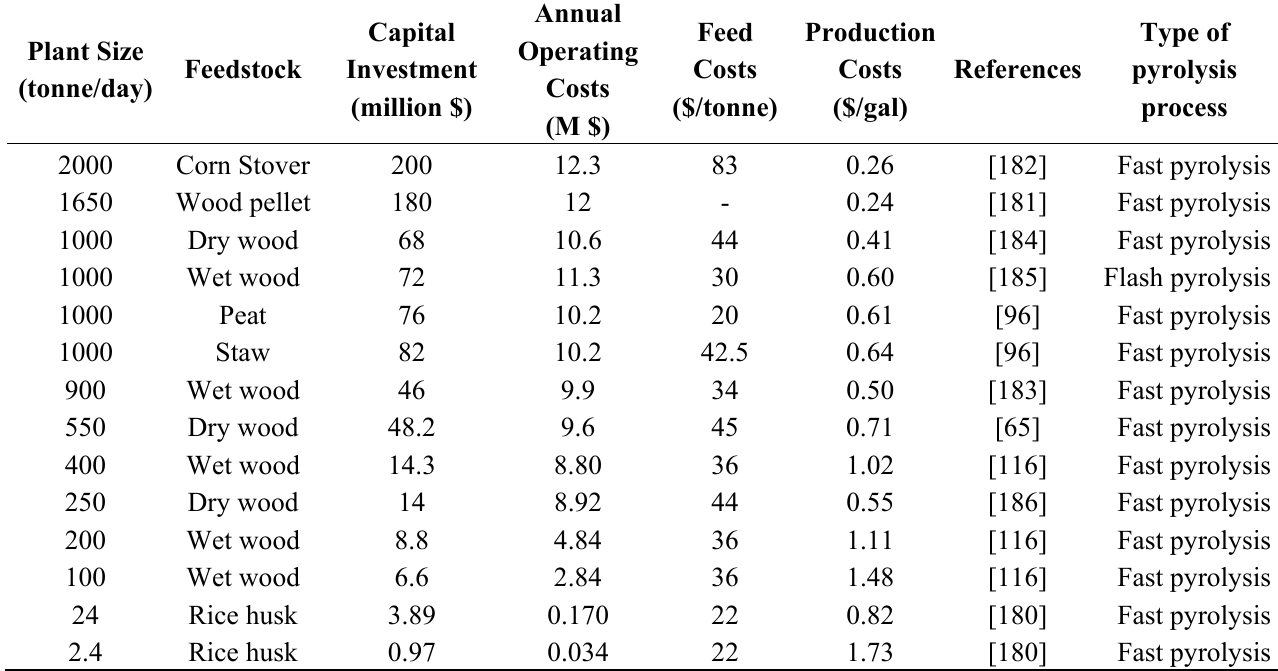
Table 12. List of the plant size, feedstock type and price, estimated bio-oil cost, and capital investment as reported in the various reports [65,96,116,180–186].